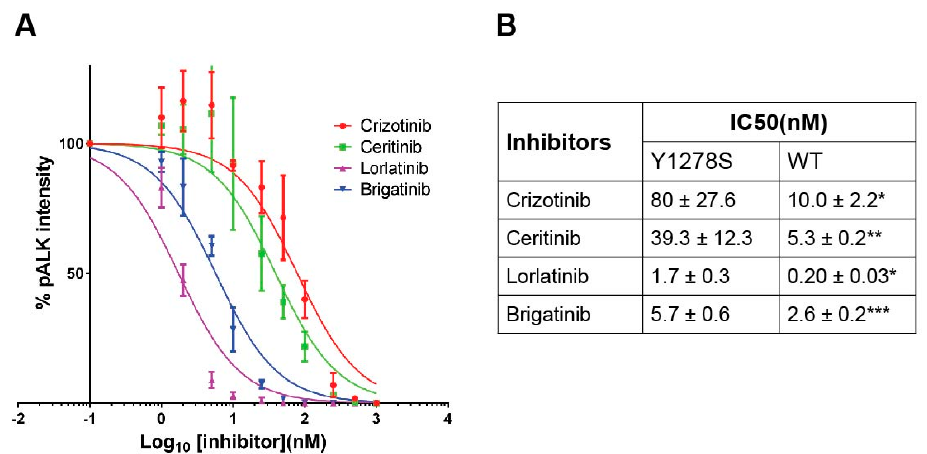
Figure 2. Inhibition profiling of ALK-Y1278S with ALK inhibitors. ( A ) PC12 cells expressing ALK-Y1278S were treated with serial dilutions of ALK inhibitors as indicated. Phosphorylation of ALK was detected with anti-pALK (Y1604) antibody and total ALK was used as internal control. Data were normalized to non-treated controls as percentage of pALK intensity. Inhibition curves were generated with GraphPad Prism 7.02. Half maximal inhibitory concentrations (IC50s) of different ALK inhibitors are shown in ( B ) as mean ± STD from three independent experiments. * Data cited from [26]. ** Data from [25]. *** Data from [24].